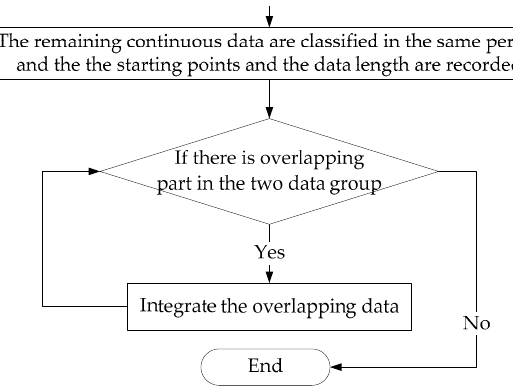
Figure 2. Flow chart of net load time division.